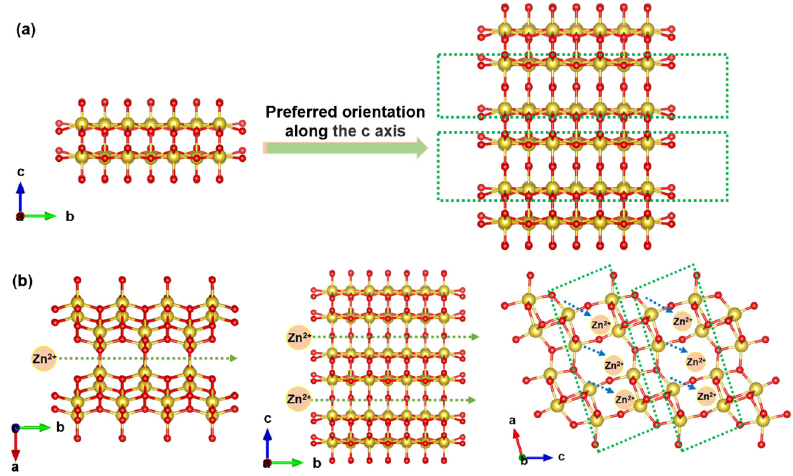
Figure 1. ( a ) Crystal structure of PO-VO2 nanosheets with preferred orientation along the c-axis. ( b ) Schematic illustration of the zinc ion transmission pathway along the interlamination direction.